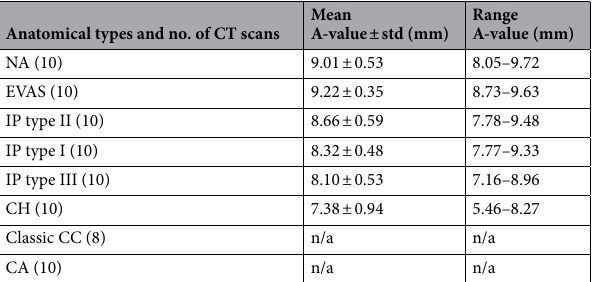
Table 1. Anatomical types of the inner ear identified along with the A-values. NA normal anatomy; EVAS enlarged vestibular aqueduct syndrome; IP incomplete partition; CH cochlear hypoplasia; CC common cavity; CA cochlear aplasia; n/a not applicable.